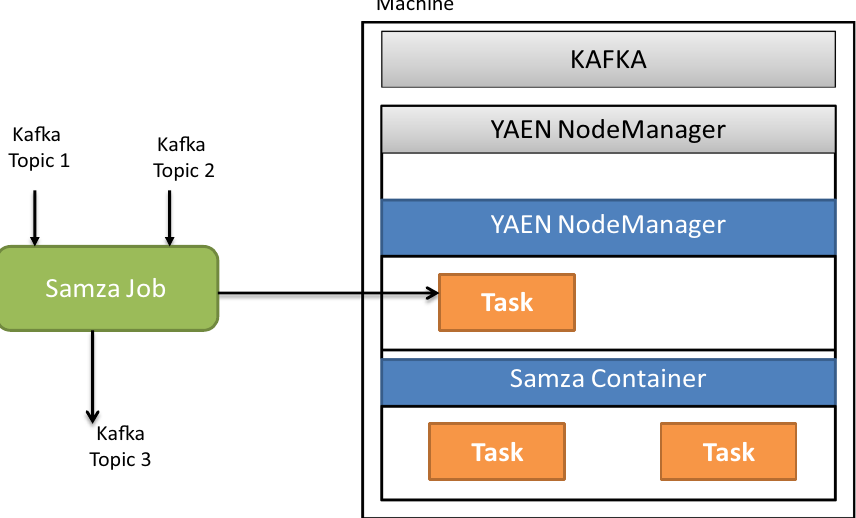
Fig. 6 Apache Samza Architecture